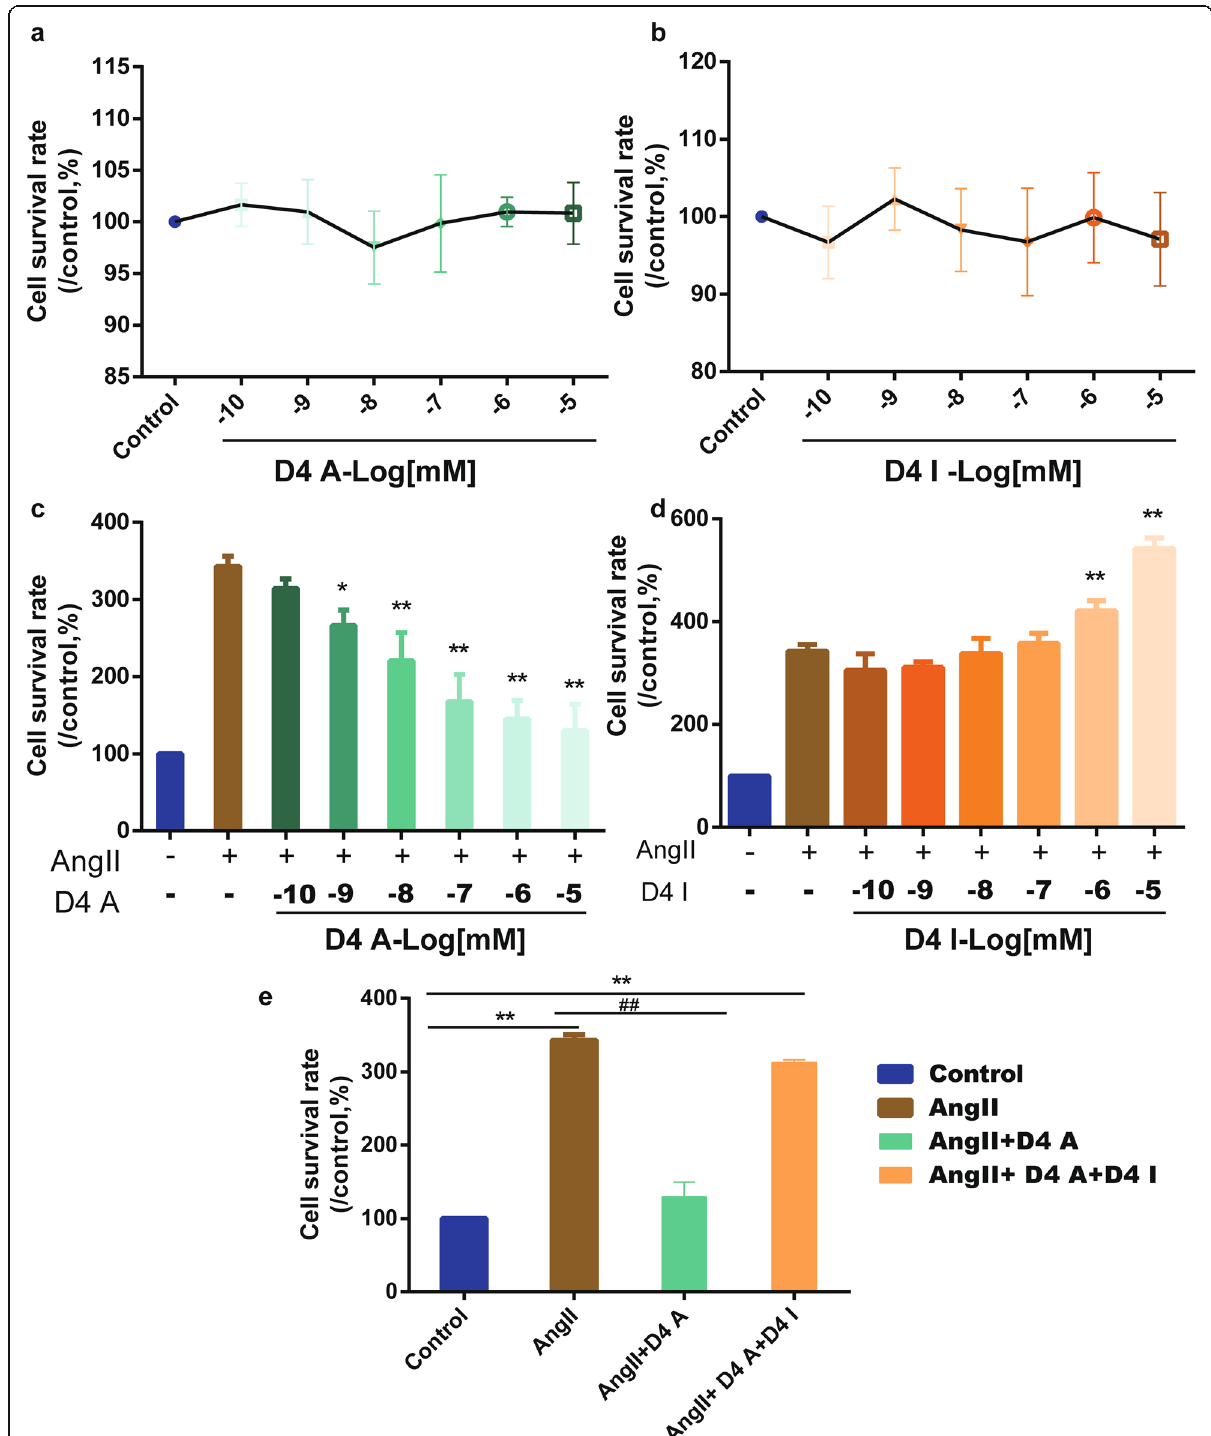
Fig. 6 (See legend on next